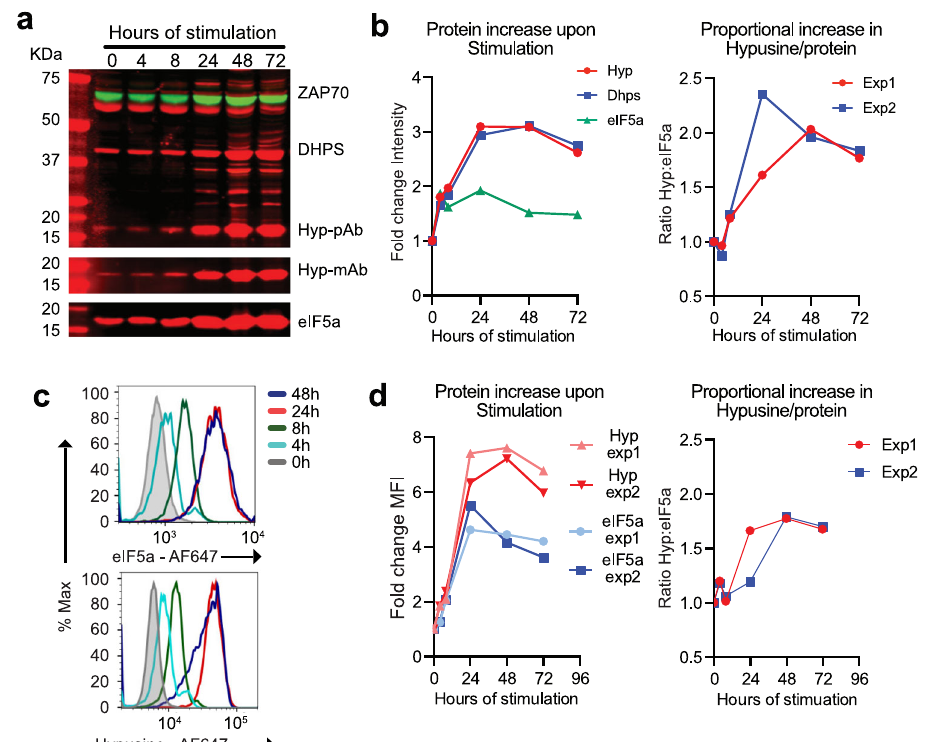
Fig. 1|HypusinationofeIF5aisinducedby Tcellactivation.a NaïveOT-1lymph node CD8 + T cells were stimulated with agonist peptide SIINFEKL for the times indicated and a western blot of total cell lysates was probed with Abs for DHPS, hypusine, eIF5a and ZAP70 as loading control, equal cell numbers were loaded in each lane. b Fold up-regulation and Hyp:eIF5a ratio were calculated relative to the 0h time point, after normalisation against ZAP70 intensity at the same time point. One representative ofthree independent experiments isshown.Lines in leftpanel: red,Hyp-pAb;blue,DHPS;green:eIF5a.Linesinrightpanel:red,Experiment1;blue, Experiment 2. c Flow cytometric analysisover time are shown of OT-1 cellsstained